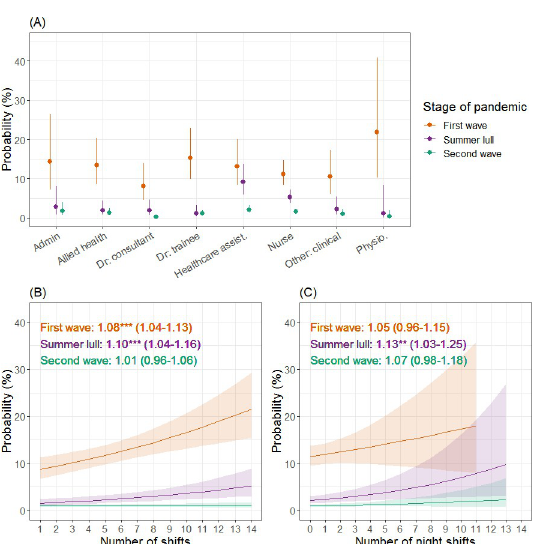
* The ethnicity of 66 HCWs was unknown.